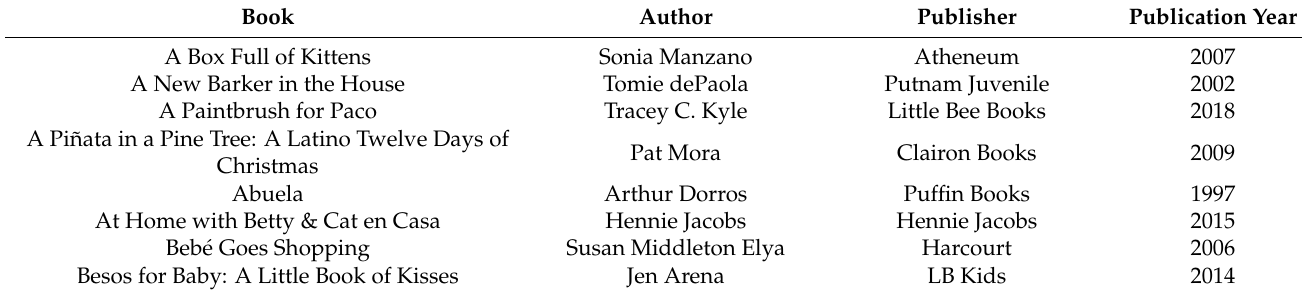
Table A1. List of codeswitching picture books in our